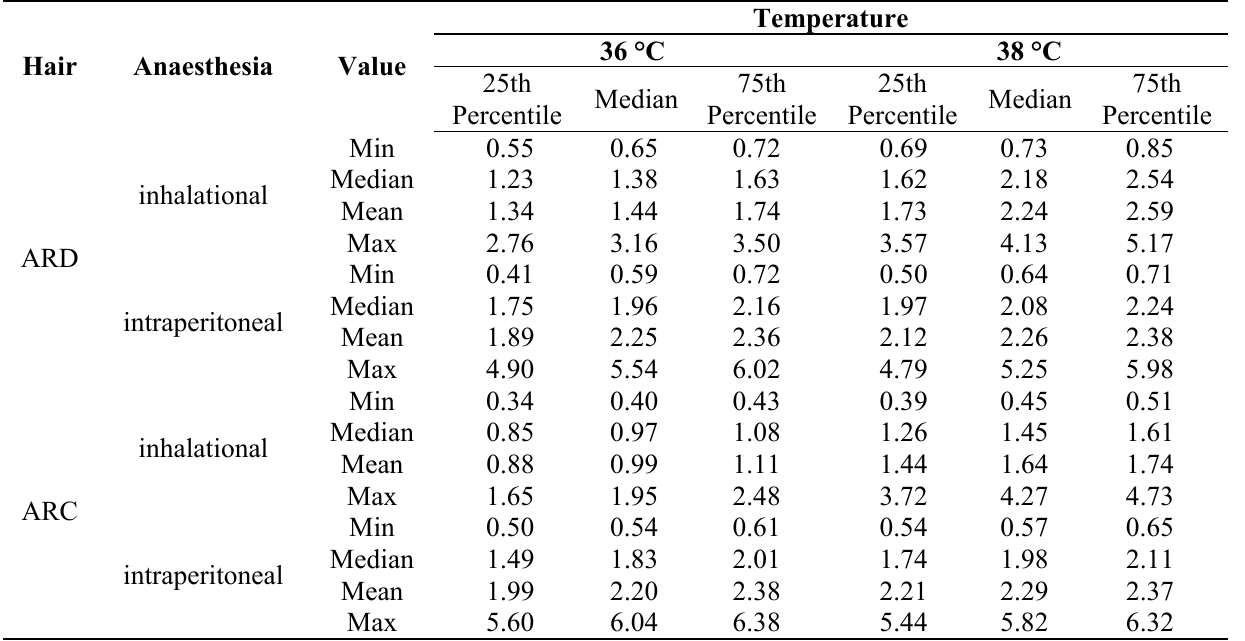
Table 2. Descriptive Statistics. These values are reported as medians and interquartile ranges for the dorsal decubitus position.